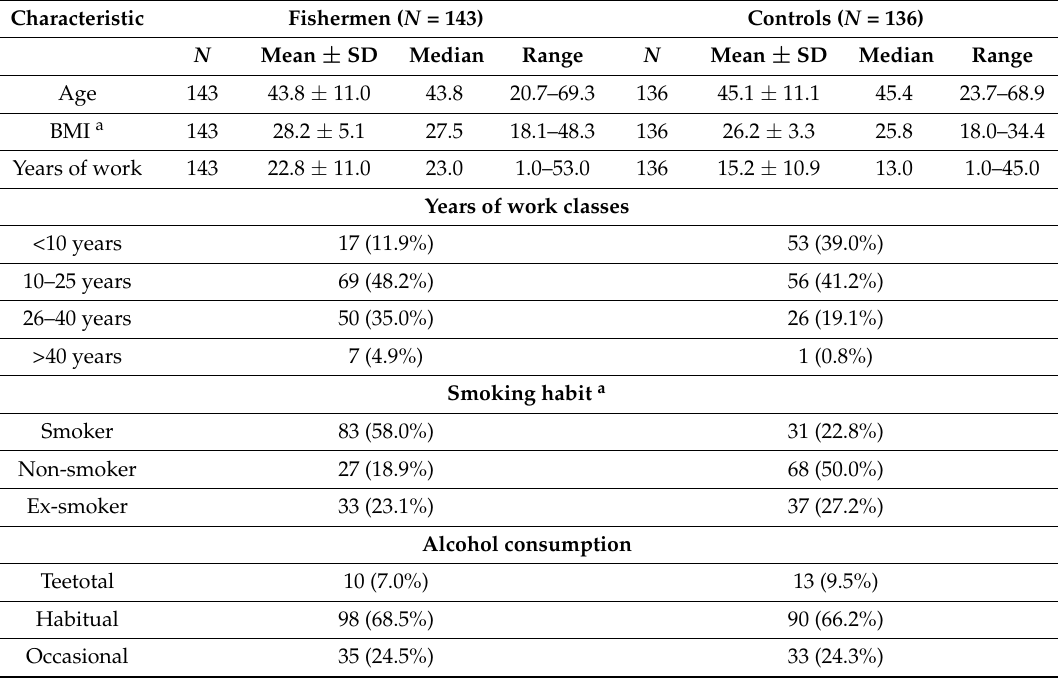
Table 1. General characteristics, years of work, and lifestyle in the fishermen and controls.